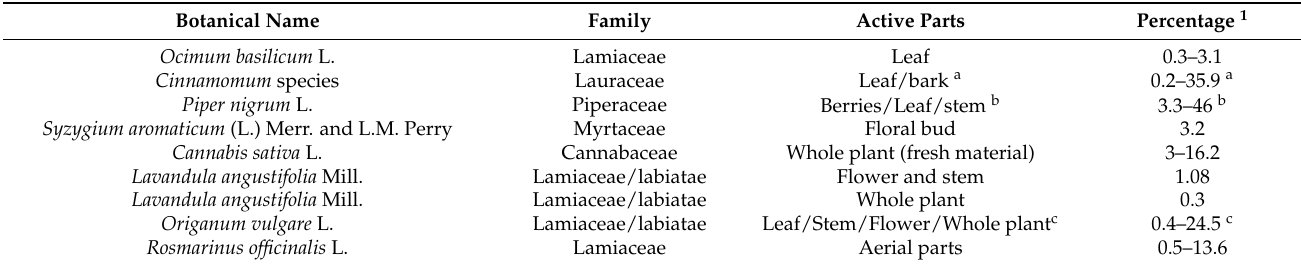
Figure 2. Chemical structure of β -caryophyllene. Table 1. Vegetable sources of β -caryophyllene and percentage composition of their essential oils (data extracted from the Essential Oil Database)